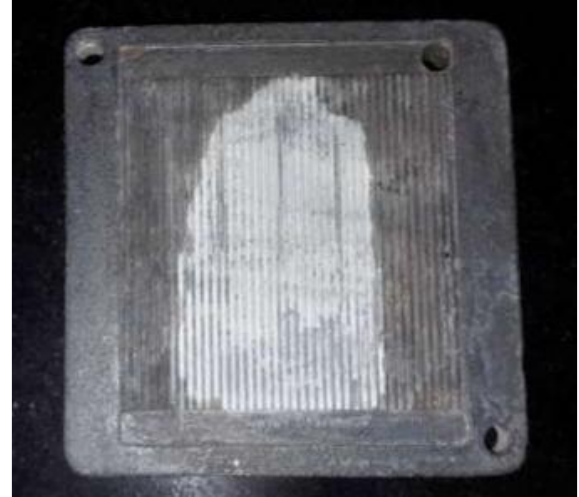
Fig. 9. White channels were not used during methanol